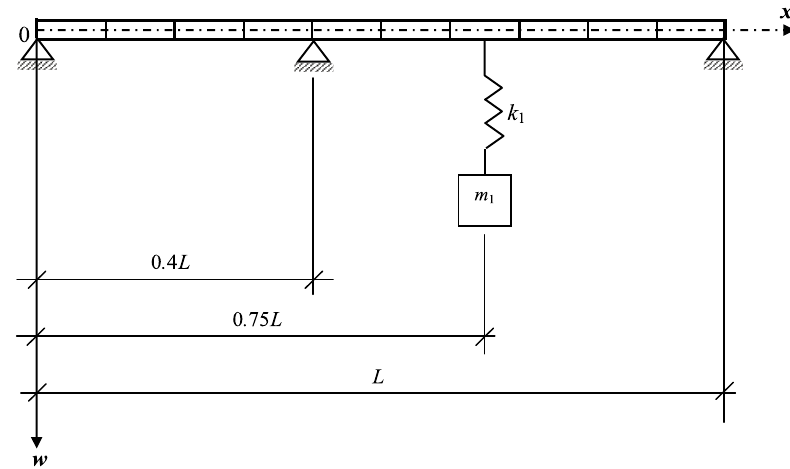
Fig. 5. A two-span Reddy-Bickford beam carrying one intermediate spring-mass